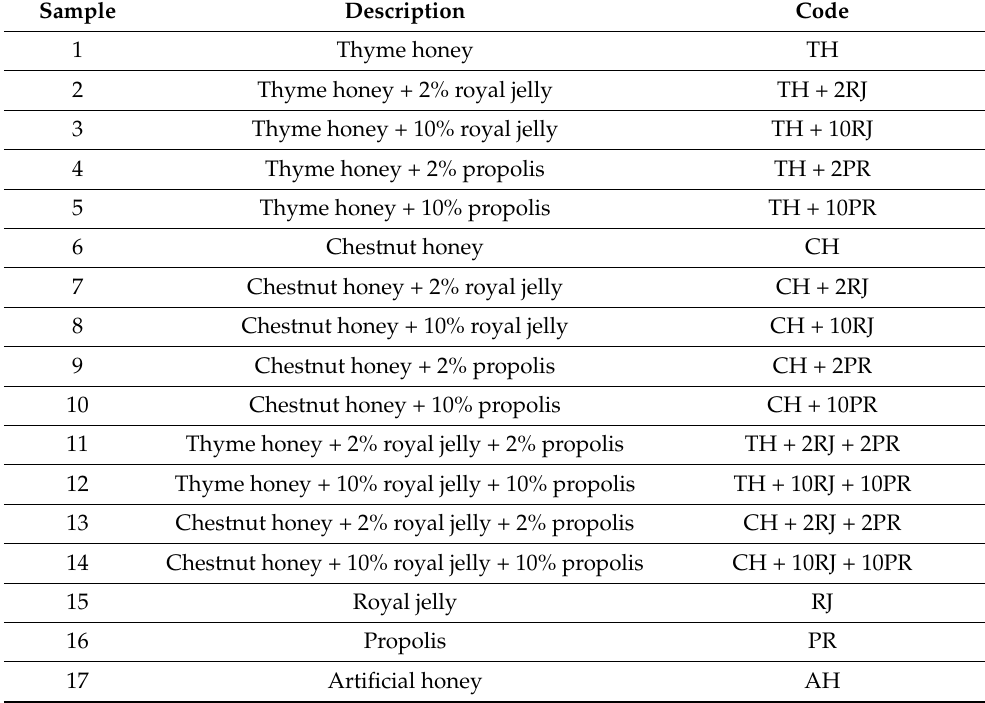
Table 2. Honey and bee products samples and